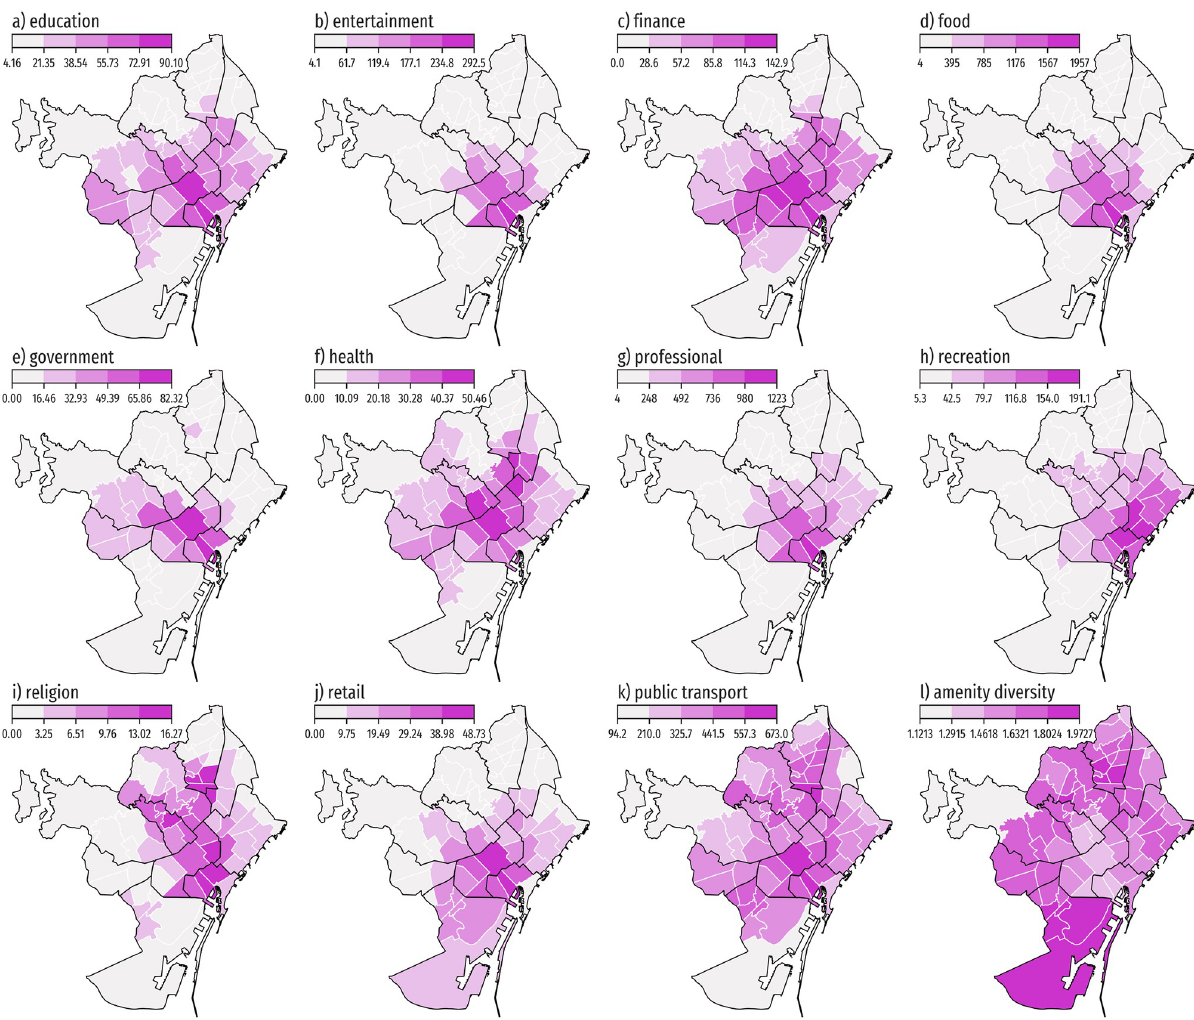
Fig 3. Distribution of mean number of reachable amenities (and its diversity) per neighborhood. Each map shows the spatial distribution of the accessibility to the following type of amenities: a) education. b) entertainment. c) finance. d) food. e) government. f) health. g) professional. h) recreation. i) religion. j) retail. k) public transport. The accessibility value per neighborhood corresponds to the mean of the accessibility values of the neighborhood inhabitants. Panel l) shows the diversity of reachable amenities in each neighborhood. Administrative boundaries are sourced